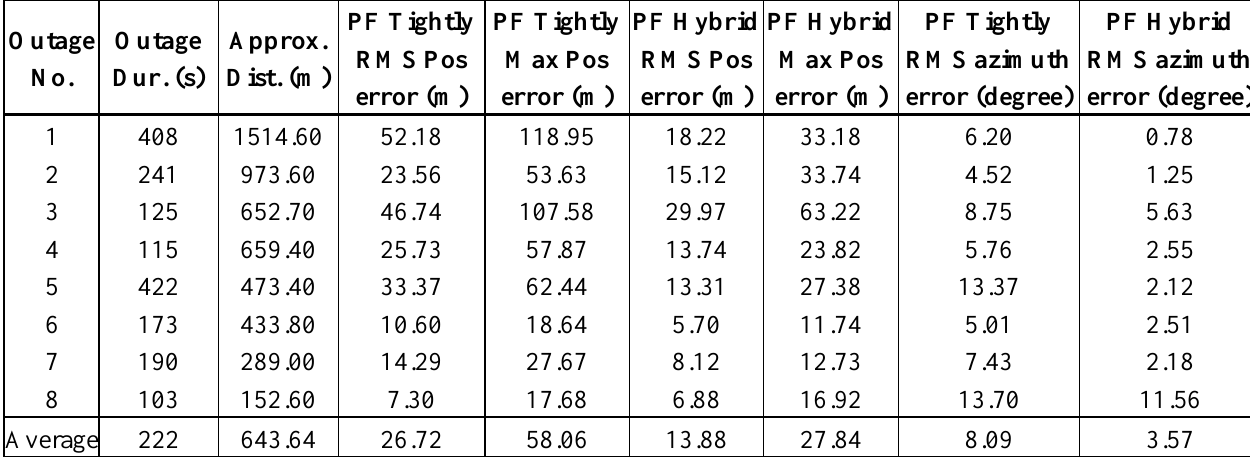
Table 4. RMS and maximum position errors and RMS azimuth errors for the natural outages whose duration exceeds 100